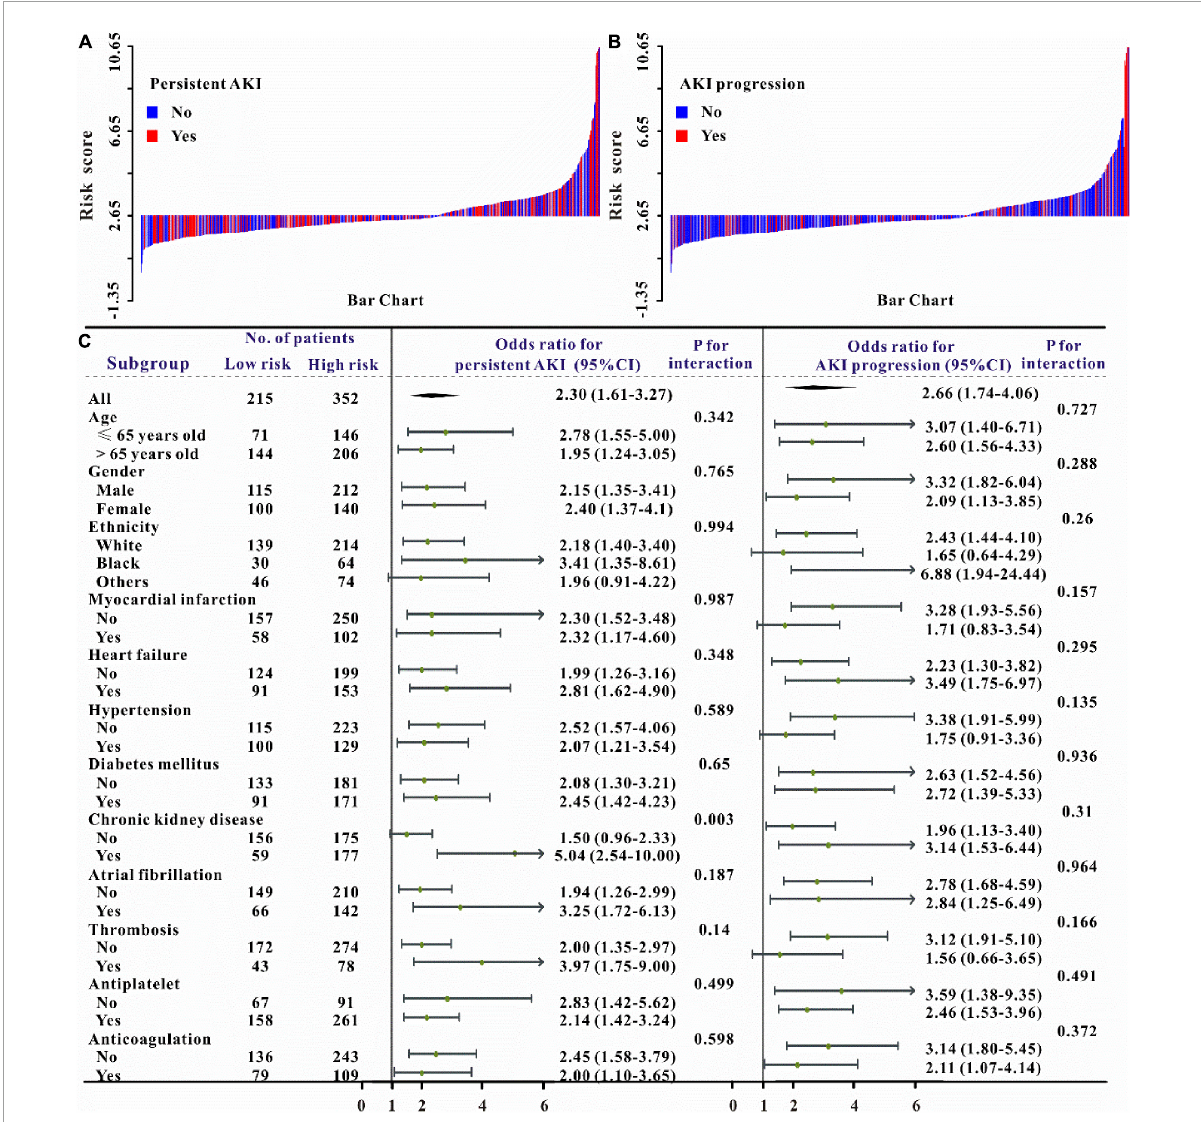
FIGURE4 Waterfall plots and forest plots of the high-risk group and low-risk group for the prediction of persistent acute kidney injury (pAKI) and AKI progression. The waterfall plot of the risk score for each patient of pAKI (A) and AKI progression (B) . The subgroup analysis of the risk score in individuals with AKI for pAKI and AKI progression (C)